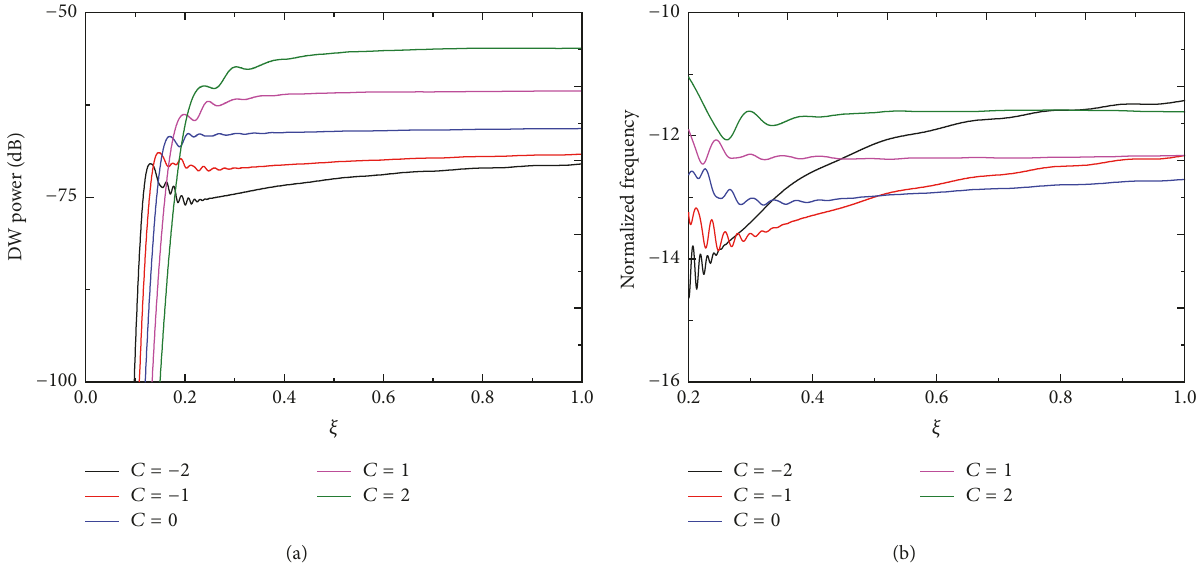
Figure 6: Evolution of the red-shift DW of relative average power (a) and central frequency (b) along the propagation distance, with different chirp but the sign of TOD is positive: dark solid curves 𝐶 = −2 ; red solid curves 𝐶 = −1 ; blue solid curves 𝐶 = 0 ; magenta solid curves 𝐶 = 1 ; olive solid curves 𝐶 = 2